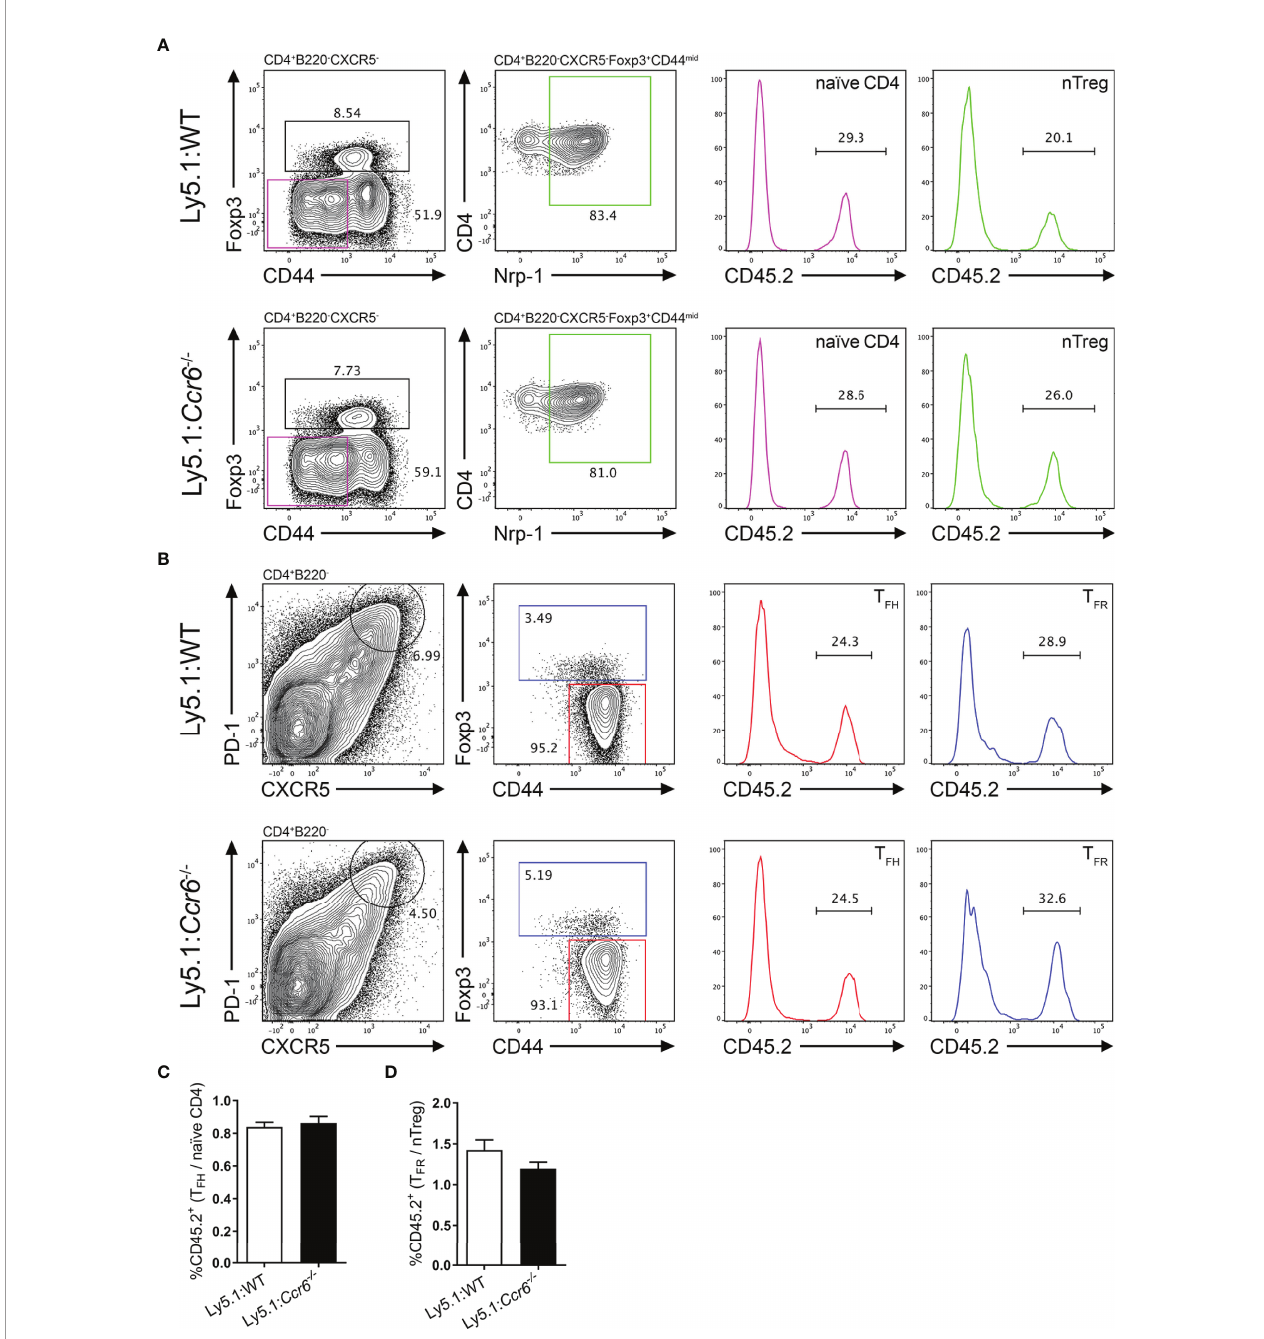
FIGURE 6 | Cell-intrinsic CCR6 function is not required for the formation of T FH and T FR cell populations. Representative gating strategies of (A) naïve CD4 T cells and nTregs, and (B) T FH and T FR cells from day 6 SRBC immunized irradiated Ly5.1 hosts reconstituted with a 1:1 ratio of Ly5.1:CD45.2 + Ccr6 +/+ (WT, top row) or CD45.2 + Ccr6 -/- (bottom row) bone marrow. (C) Ratio of CD45.2 + T FH cells:CD45.2 + naïve CD4 T cells in Ly5.1:WT and Ly5.1: Ccr6 -/- chimeras. (D) Ratio of CD45.2 + T FR cells:CD45.2 + nTregs in Ly5.1:WT and Ly5.1: Ccr6 -/- chimeras. (A – D) n=6/chimera group, ± SEM, two-tailed unpaired Student ’ s t